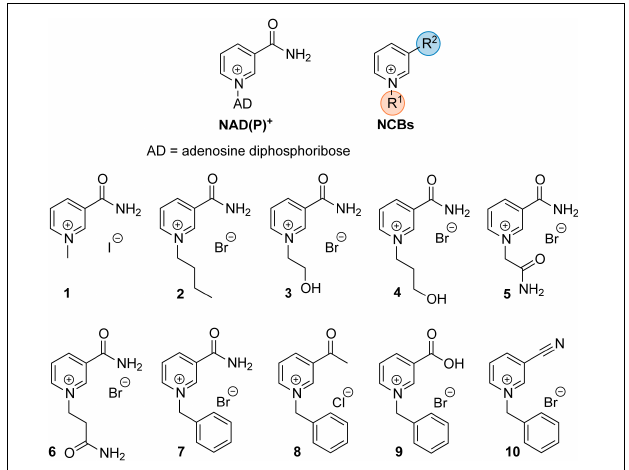
FIGURE 1 | Schematic structure of the natural cofactor NAD(P) + (Left) and synthetic NCBs (Right and Bottom). R 1 and R 2 denote the varying substituents at the pyridinium nitrogen and the C-3 position in NCB 1 – 10